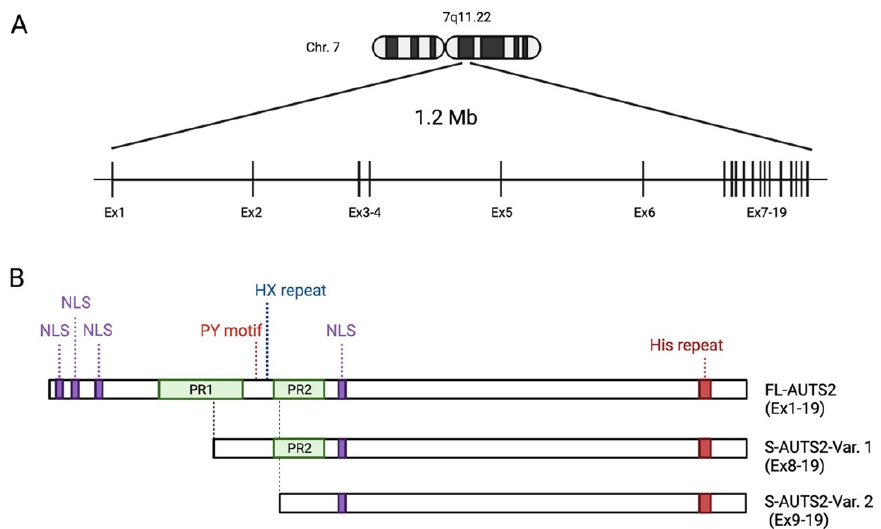
Figure 1. Schematic showing the human AUTS2 gene genomic region and the structure of AUTS2 protein isoforms: ( A ) Genomic structure of human AUTS2 locus on chromosome 7q11.2 (Chr. 7), consisting of 19 exons (Ex). ( B ) Schematic representation of the protein structure of full-length and C-terminal short AUTS2 isoforms. The location of predicted domains, motifs, and other characteristic sequences are shown. NLS: nuclear localization signal sequence; PR: proline-rich domains. Illustration created with BioRender.com.